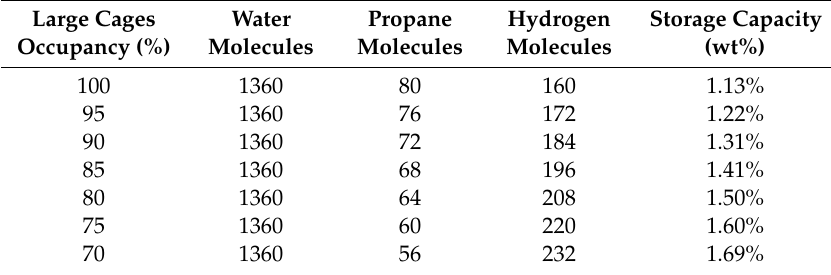
Table 2. Estimated-hydrogen storage capacity with respect to the large-cage occupancy. Large Cages Water Propane Hydrogen Storage Capacity Occupancy (%) Molecules Molecules Molecules